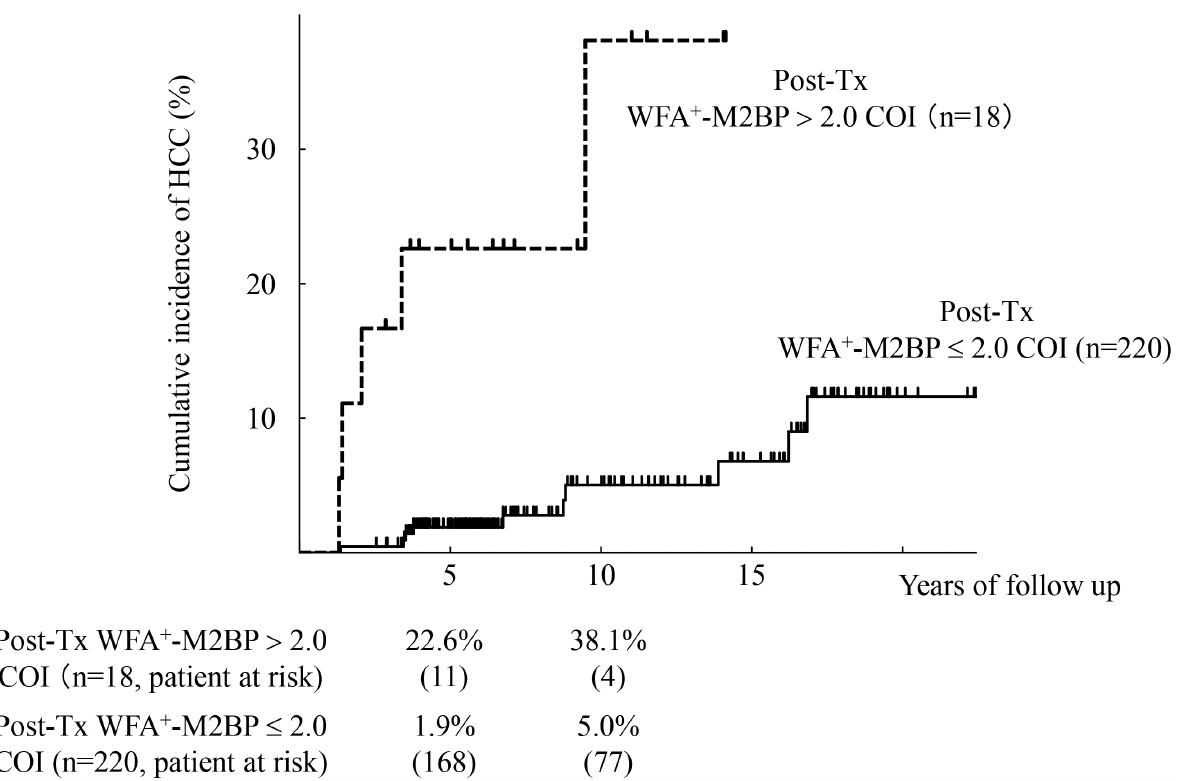
Fig 1. Cumulative incidence of hepatocellular carcinoma (HCC) according to post-treatment WFA + -M2BP values. Cumulative incidences of HCC according to post-treatment WFA + -M2BP values were analyzed using the Kaplan-Meier method. The black solid and dotted lines indicate the stratified post- treatment WFA + -M2BP values with a COI (cid:5) 2.0 and a COI > 2.0, respectively. The incidence rate differed significantly between the two groups ( P < 0.0001 by the log-rank test). The numbers of patients at risk at each time point are shown below the